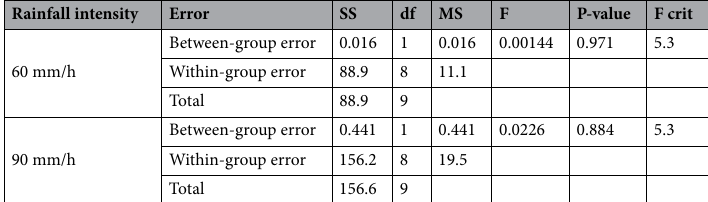
Table 2. Variance analysis for different slopes.